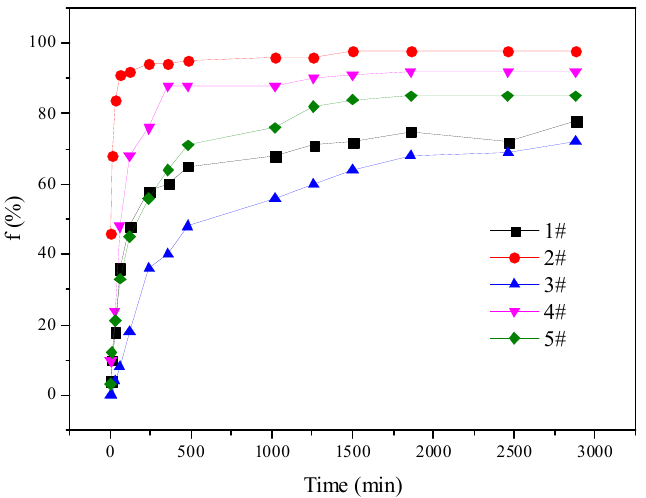
Figure 3. The water separation rates of different viscosity reducer systems over time.